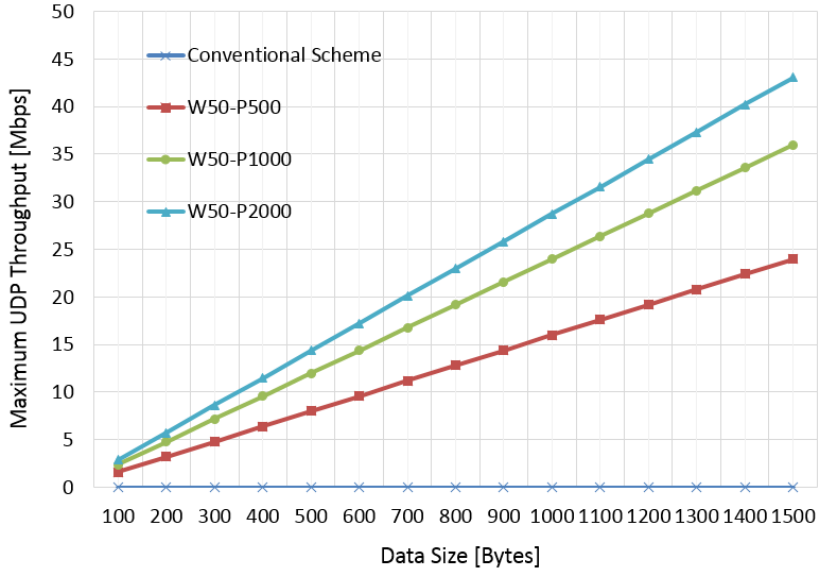
Figure 6. Maximum user datagram protocol (UDP) throughput vs. data size.